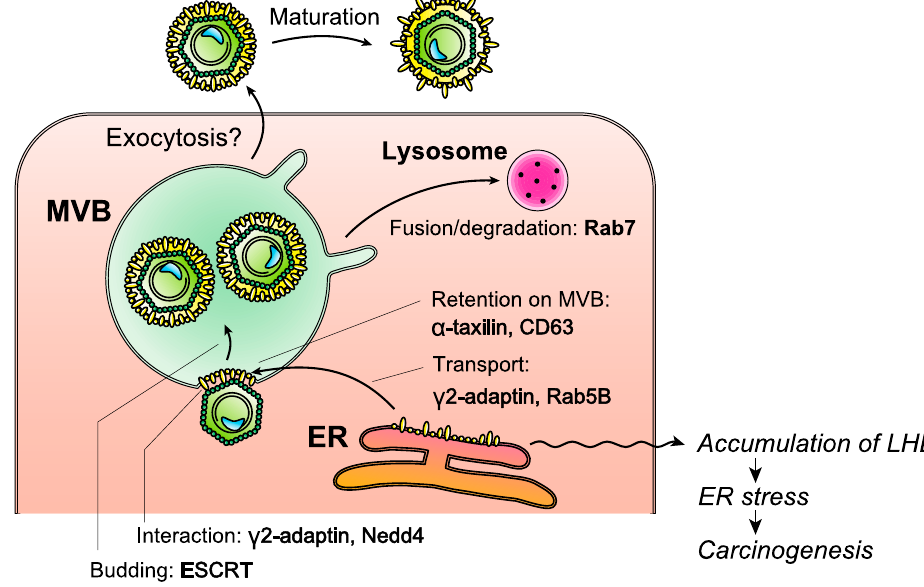
Figure 3. Model depicting the steps of HBV envelope formation. Molecules/organelles in the cells that are utilized for the envelope formation are shown. Nucleocapsid is considered to interact with preS1/preS2 of LHBs on the cytoplasmic side on the multivesicular body (MVB) membrane and buds into the MVB with the action of endosomal sorting complex required for transport (ESCRT). After the release from cells, probably via exocytosis, the position of the preS1/preS2 domains changes to the luminal side to attach to the surface of hepatocytes. LHBs accumulation in the endoplasmic reticulum (ER), which is accelerated by preS mutation, leads to carcinogenesis.